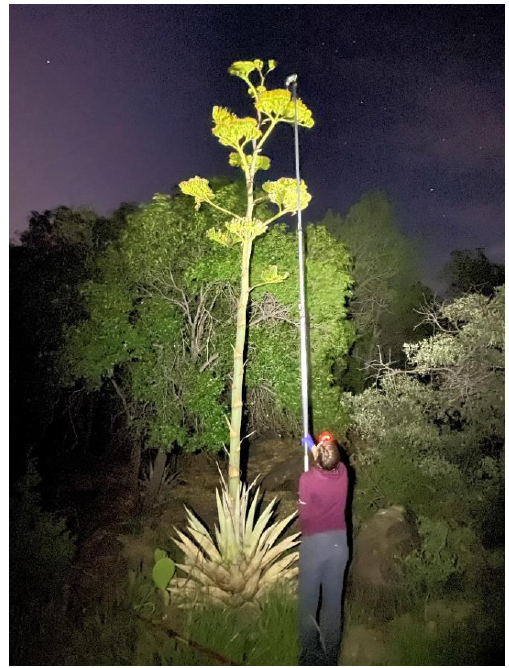
Figure 2. Swabbing agave flowers visited by L. nivalis using a telescoping pole with a swab affixed to the top.